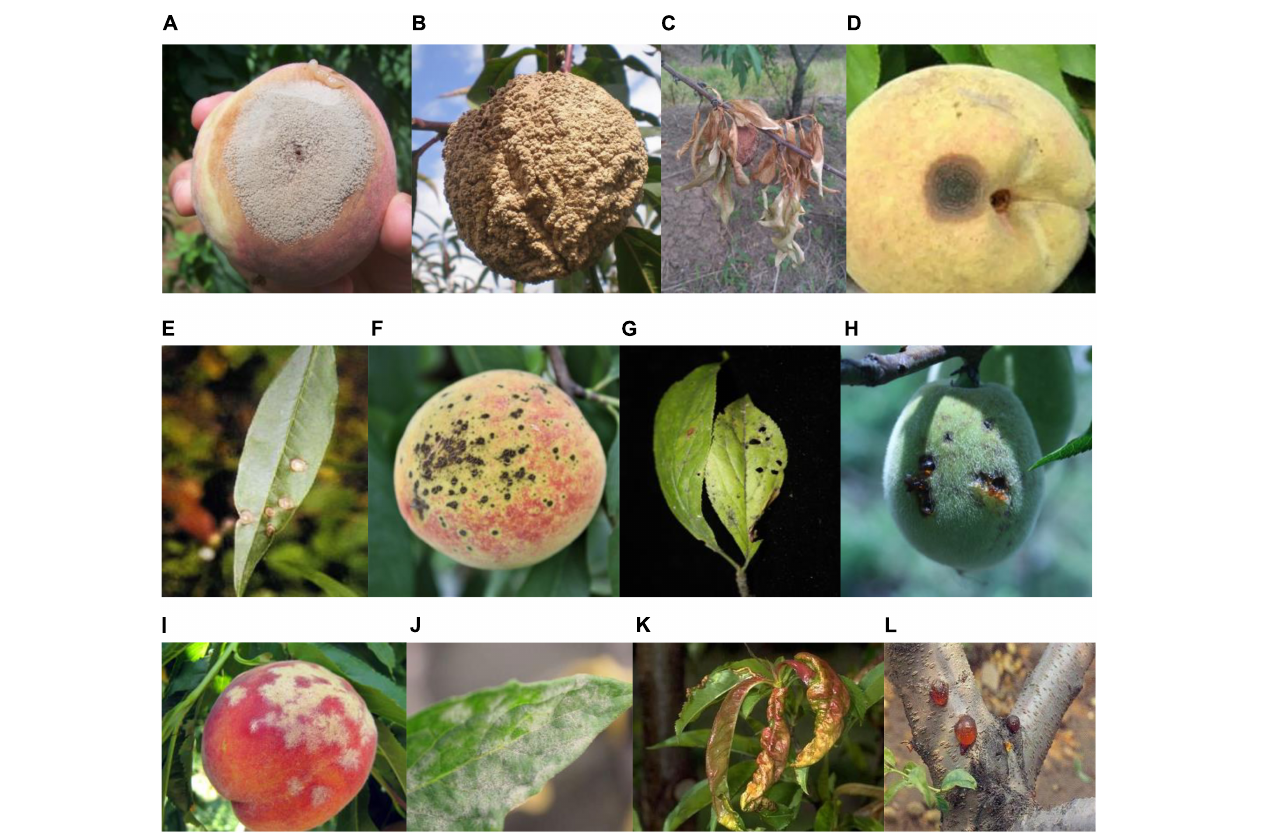
FIGURE 1 | Major plant diseases of peach. (A) Brown rot of fruit, (B) brown rot of fruit, (C) brown rot of leaf, (D) anthracnose of fruit, (E) anthracnose of leaf, (F) scab of fruit, (G) scab of leaf, (H) bacterial shot hole of fruit, (I) powdery mildew of fruit, (J) powdery mildew of leaf, (K) leaf curl of a leaf, and (L) gummosis of a branch (Yao et al., 2021).